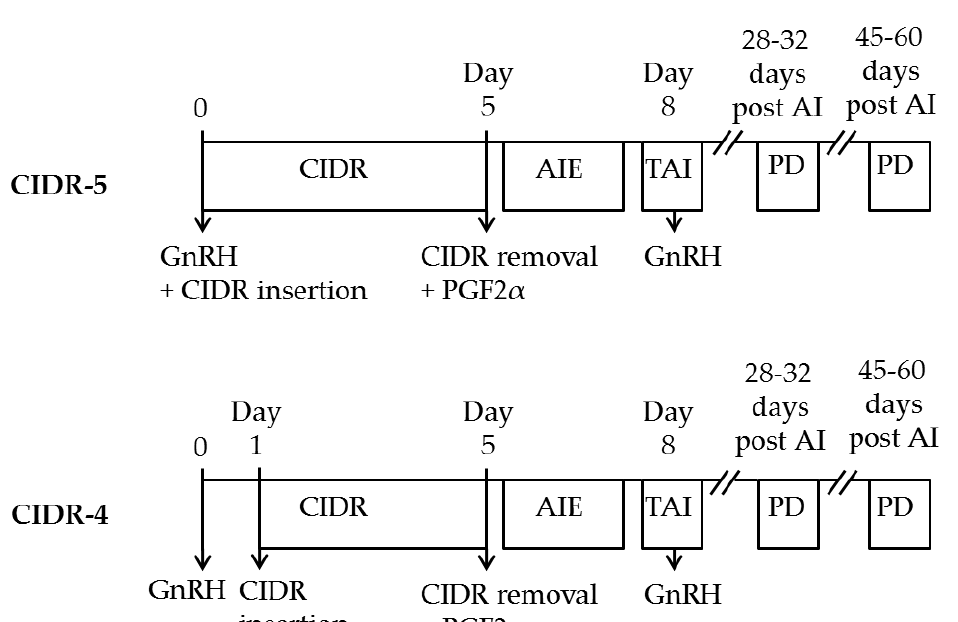
Figure 1. Diagrammatic representation of experimental design of treatments. CIDR, controlled internal drug release; TAI, timed artificial insemination; PD, Pregnancy diagnosis. Heifers at five locations were assigned randomly to receive a synchro- nization of ovulation and TAI. Both treatments consisted of a GnRH injection on day 0. CIDR inserted on day (d) 0 (CIDR-5; n = 206) or d 1 (CIDR-4; n = 192) of synchronization program. On d 8, TAI and GnRH administration were concurrently conducted. Heifers detected in estrus up to 24 h prior to TAI were inseminated without GnRH administration